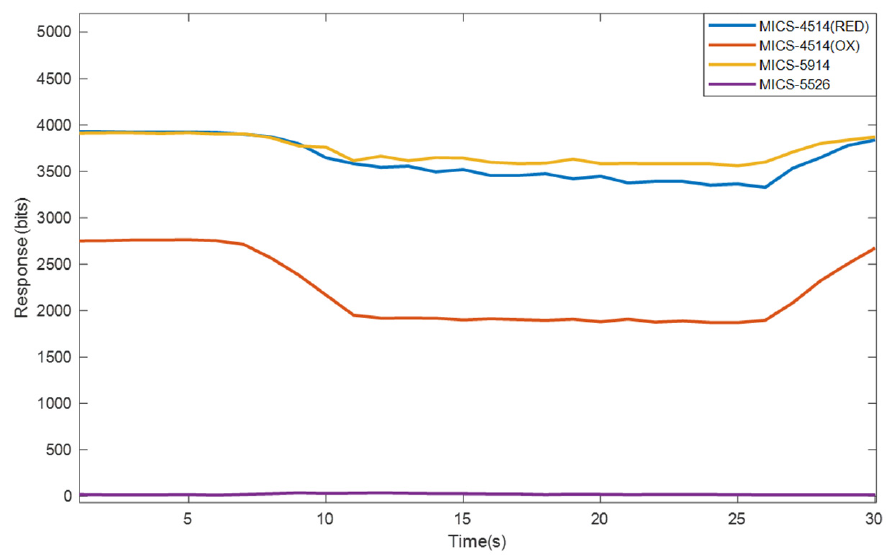
Figure 9. E-nose response to a clean air sample.